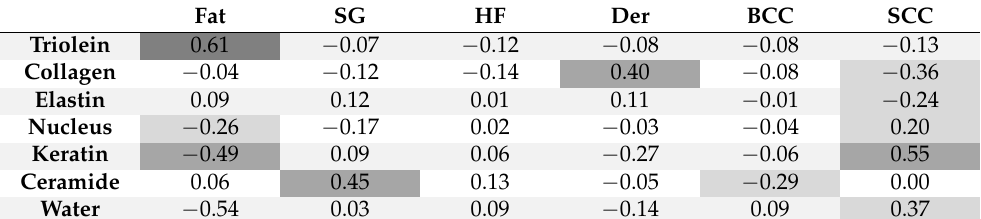
Table 2. Pearson correlation coefficients between biocomponents and tissue